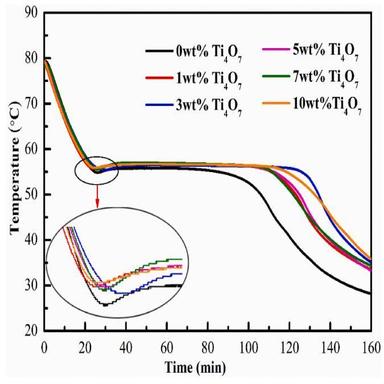
Step-cooling curves of SDC modified by different contents of Ti4O7.